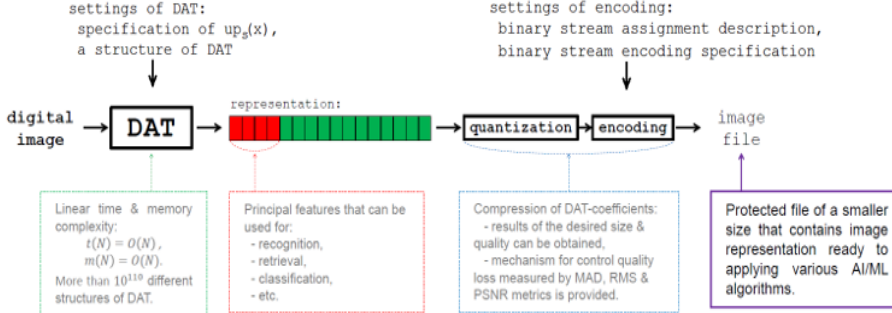
Figure 17. The principal steps of image processing by atomic functions.